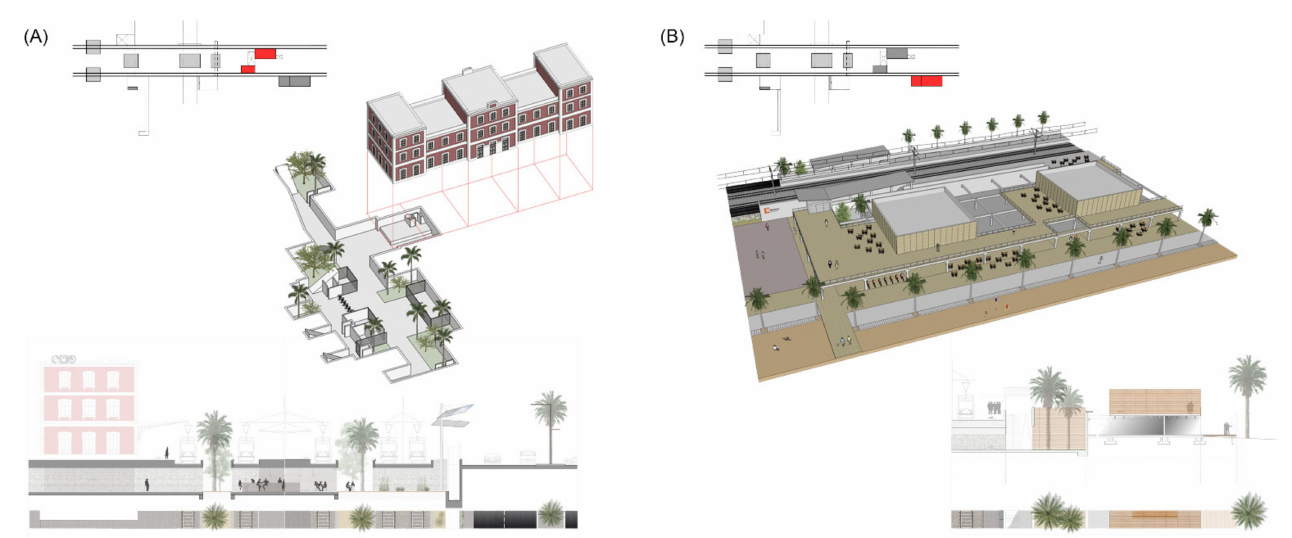
Figure 17. Standardized solutions for building typologies (Source: authors’ own). ( A ) Urban side, civic way. ( B ) Maritime side,